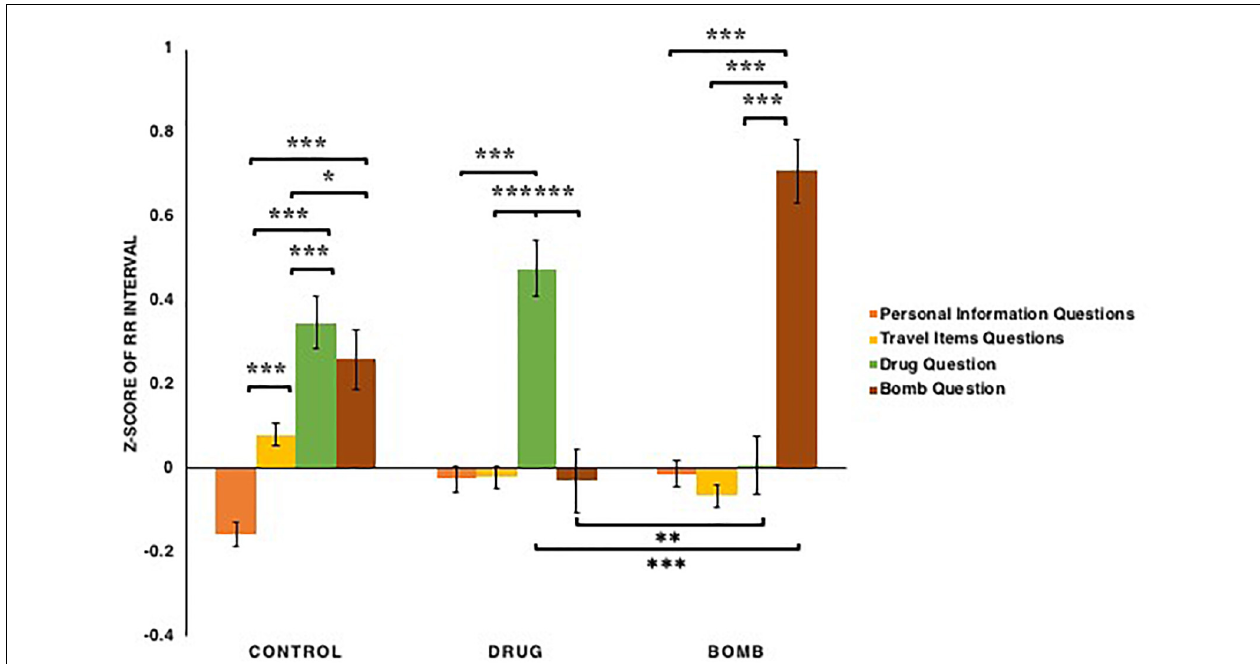
FIGURE 8 | The z -scores of the RR interval among participants in the bomb, control and drug conditions across the four types of questions: basic personal information, carrying common travel items, carrying drugs, carrying a bomb. Note that ∗ p < 0.05, ∗∗ p < 0.01, ∗∗∗ p < 0.001. The error bars